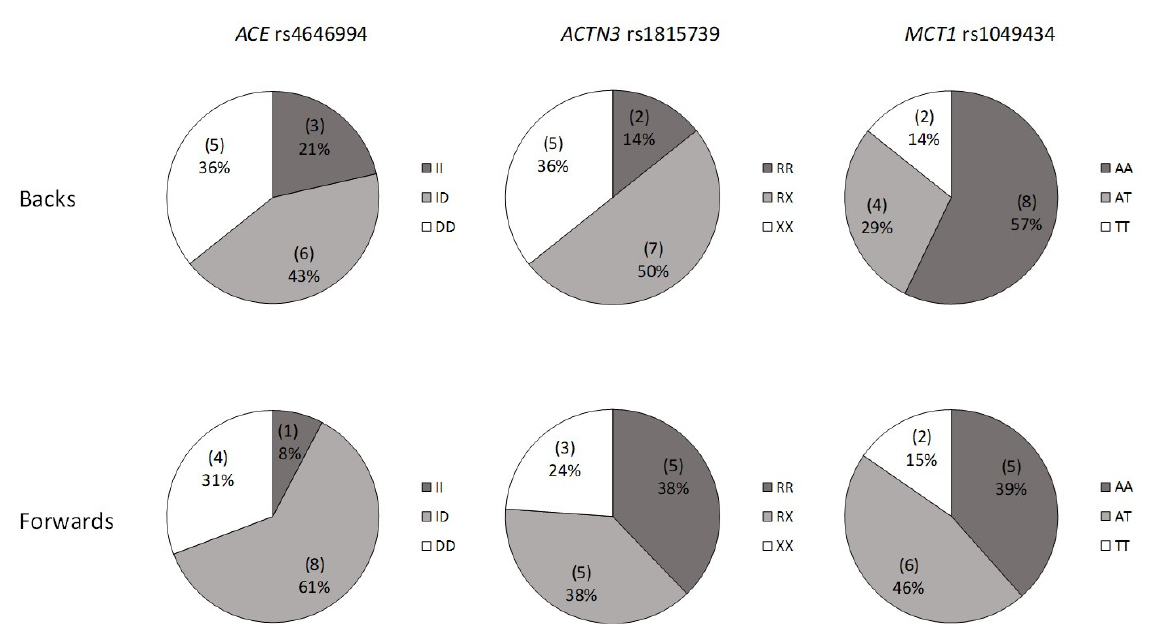
Figure 4. Genotype distribution in elite rugby union players for playing position.